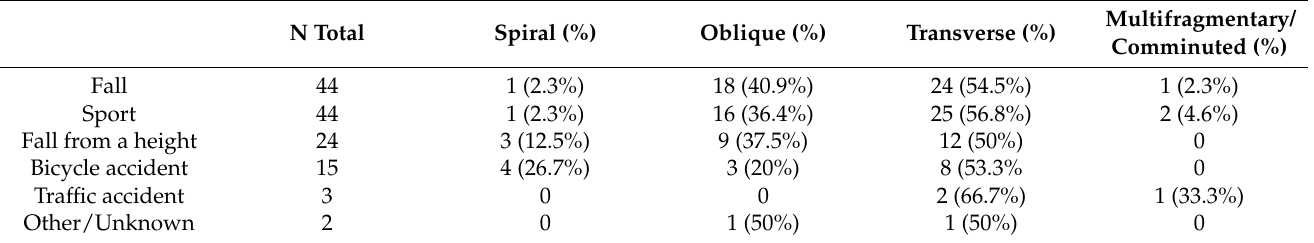
Table 2. Fracture type by mode of injury.